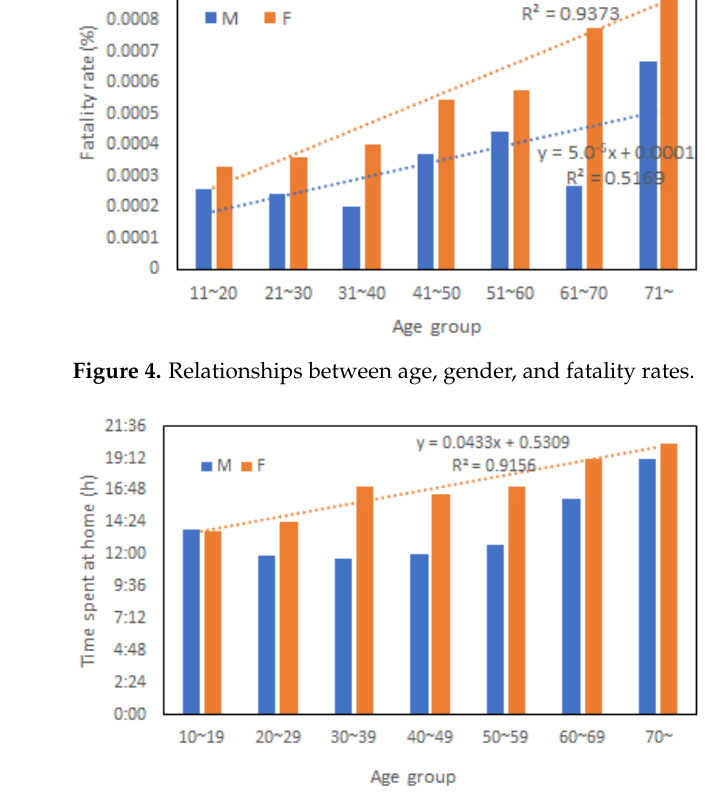
Figure 5. Gender difference in time spent at home for different age groups.